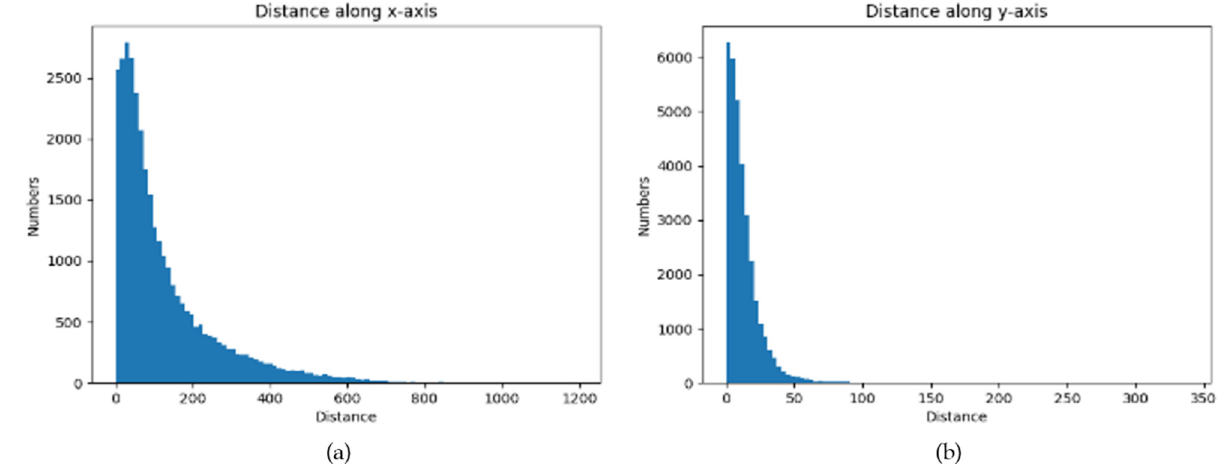
Figure 1. ( a ) Histogram of small objects, ( b ) the vanishing point distance.